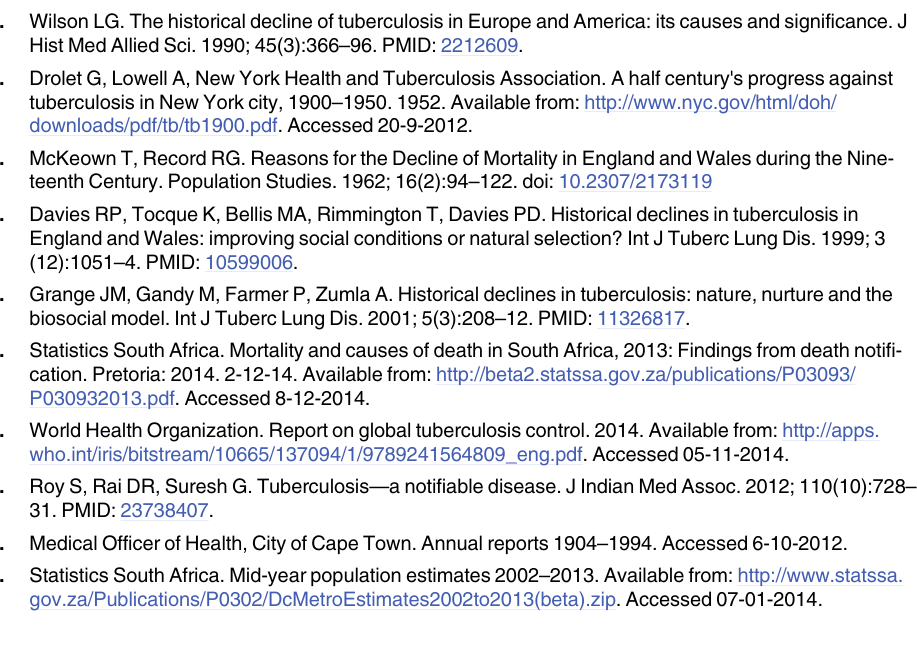
S3 Fig. TB notification rates by 5 year age group per decade over time in Cape Town, New York and London. (TIF) S4 Fig. Cape Town TB notification rate (A) and TB mortality rate (B) over time stratified by population group. (TIF) S1 Table. Age-stratified TB notification rates per decade over time in Cape Town, New York and London. Note. Age-stratified rates in Cape Town were not available prior to 1930. Cape Town rates for 2002 and 2010 include TB in HIV-infected